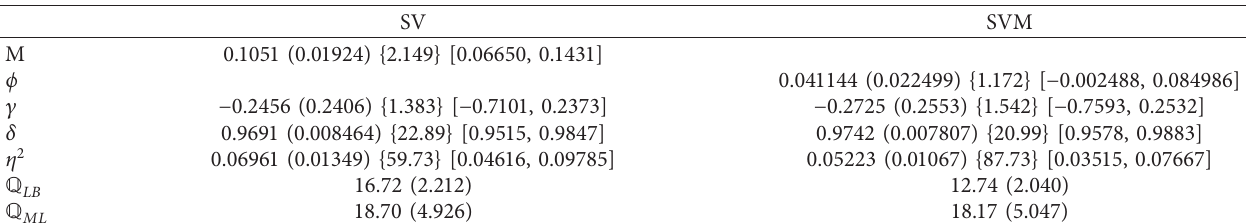
Table 3: Parameter posterior means, standard deviations (in parentheses), inefficiency factors (in braces), and 95% intervals (in square brackets) for the SV and SVM models using Kalman filter-based simulation smoother algorithm.